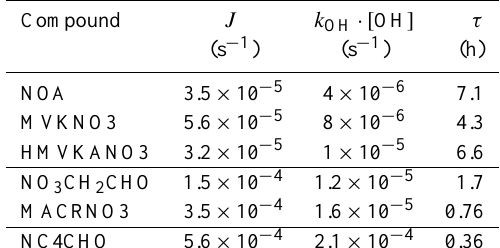
Table 3. Sink rates of carbonyl nitrates due to photolysis ( J ) and re- action with OH ( k OH ·[ OH ] ), and overall lifetime τ = 1/( J + k OH · [ OH ] ). k OH taken as the average of Neeb (2000) and MCMv3.2. [OH] = 5 × 10 6 molec.cm − 3 . Photolysis rates calculated with TUV for 30 ◦ solar zenith angle and 300DU ozone. Hydroxy group ef- fects in MVKNO3, MACRNO3 and HMVKANO3 photolysis were neglected in this